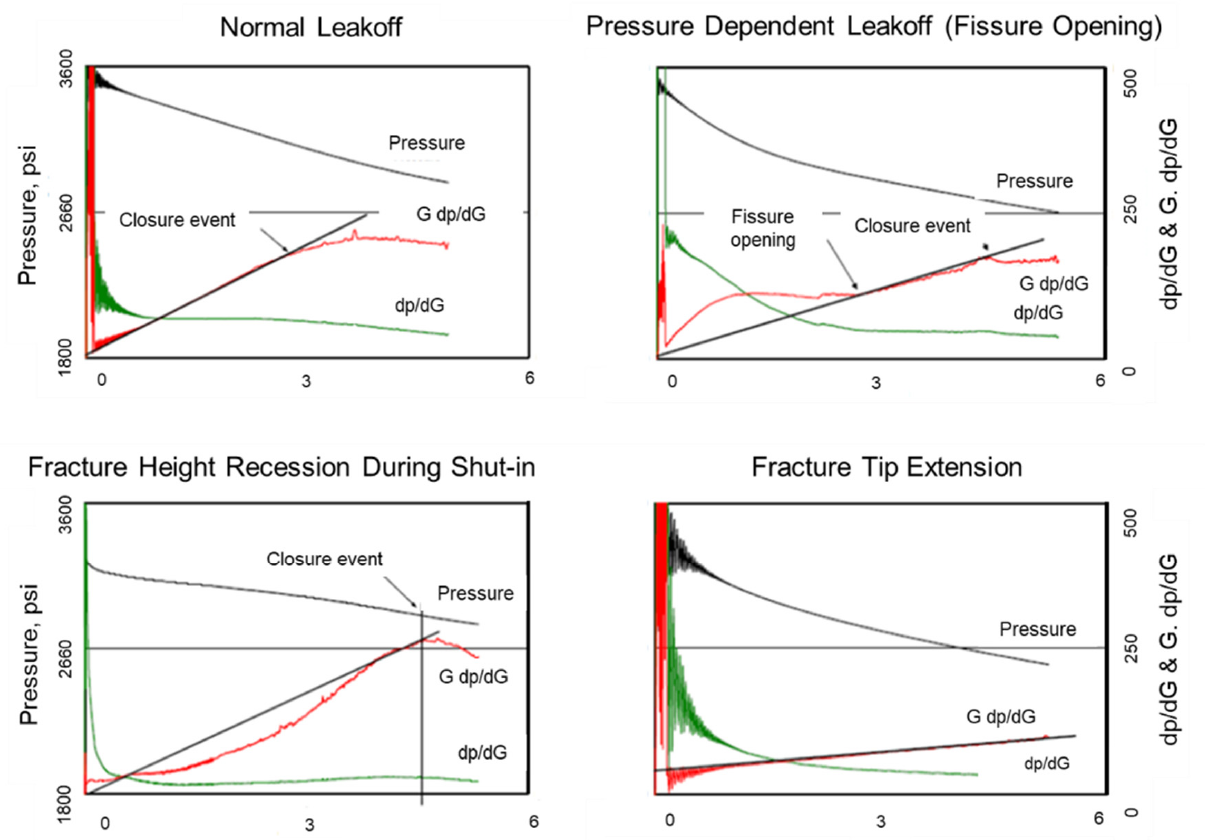
Figure 5. G-function characteristics for different leak-off mechanisms [41].